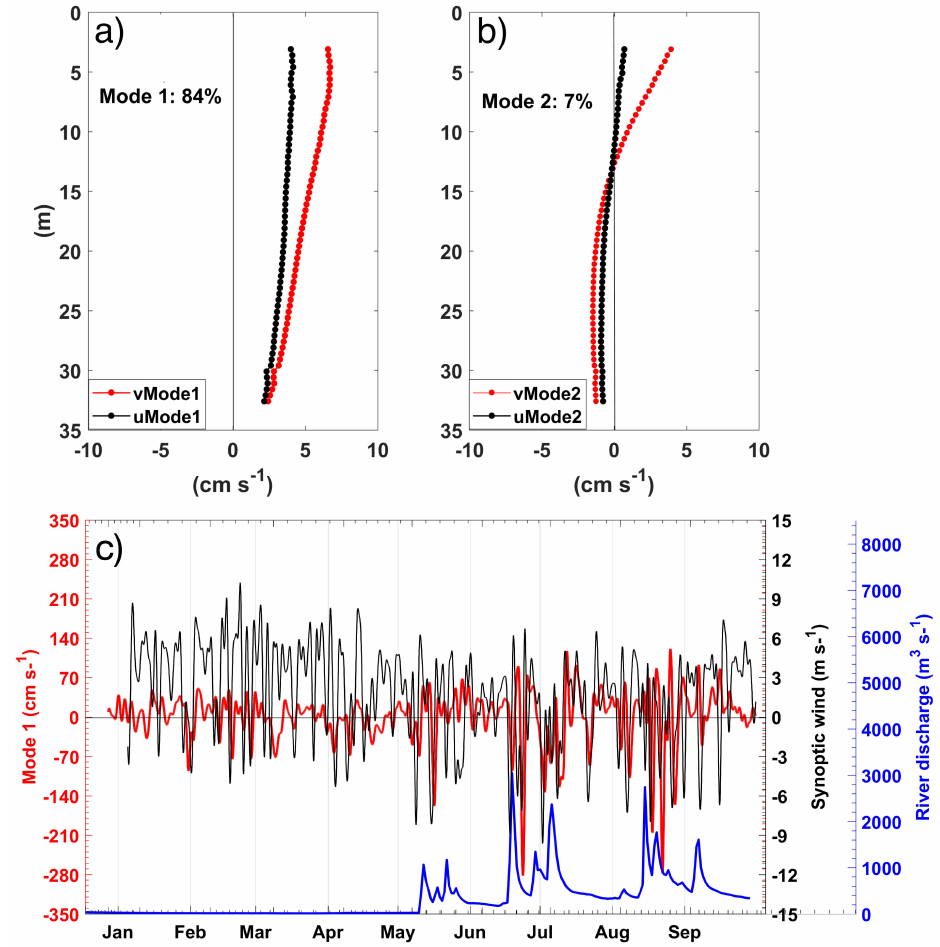
Figure 8. Vertical structure of ( a ) first and ( b ) second EOF. ( c ) Time series of the first vertical mode (red line), synoptic alongshore wind (black line), and the river discharge (blue